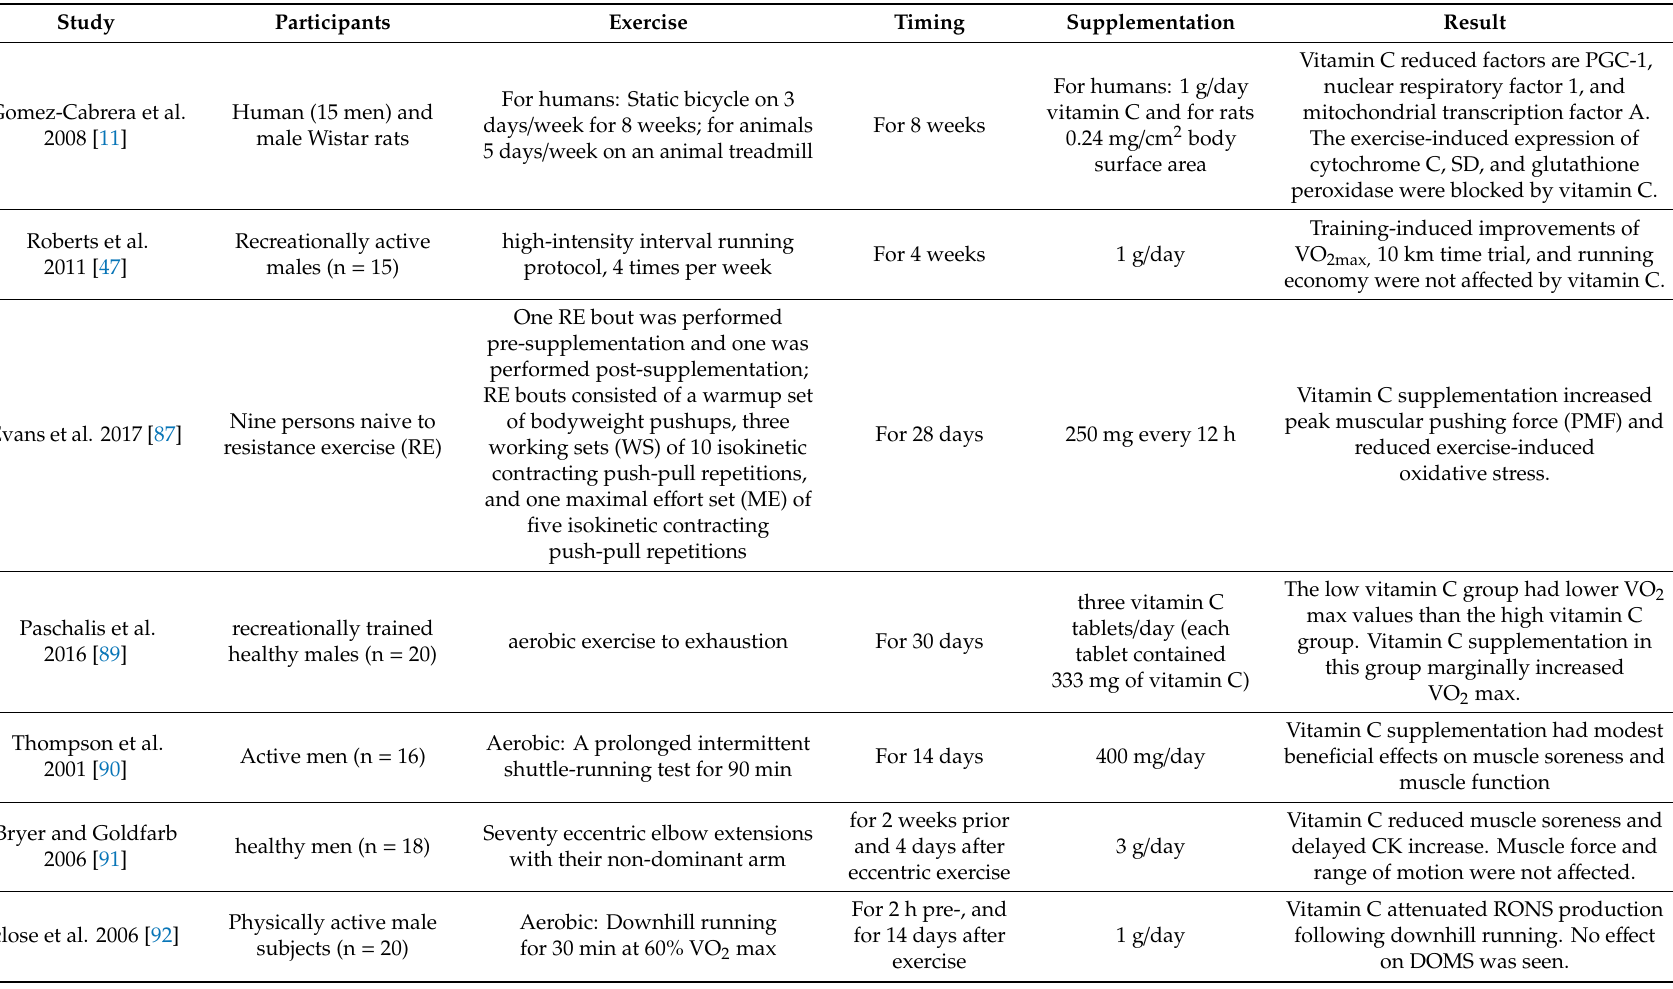
Table 3. E ff ects of vitamin C supplementation on exercise performance